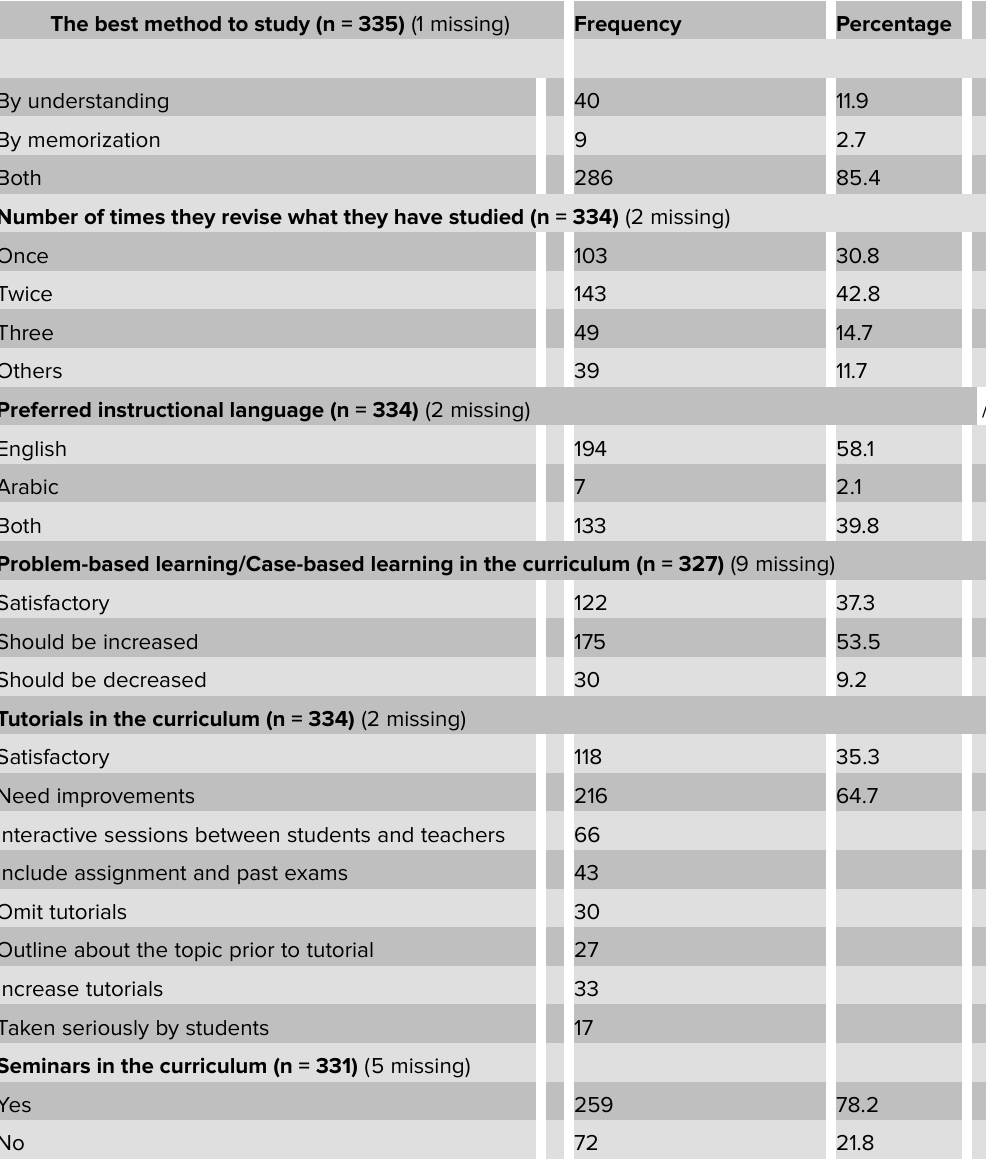
Table 2: Students’ reflections on study methodology and some instructional